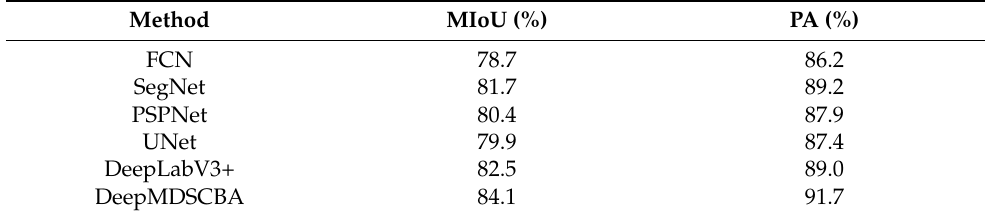
Table 12. Segmentation performance for apple images with an unseen rot degree.